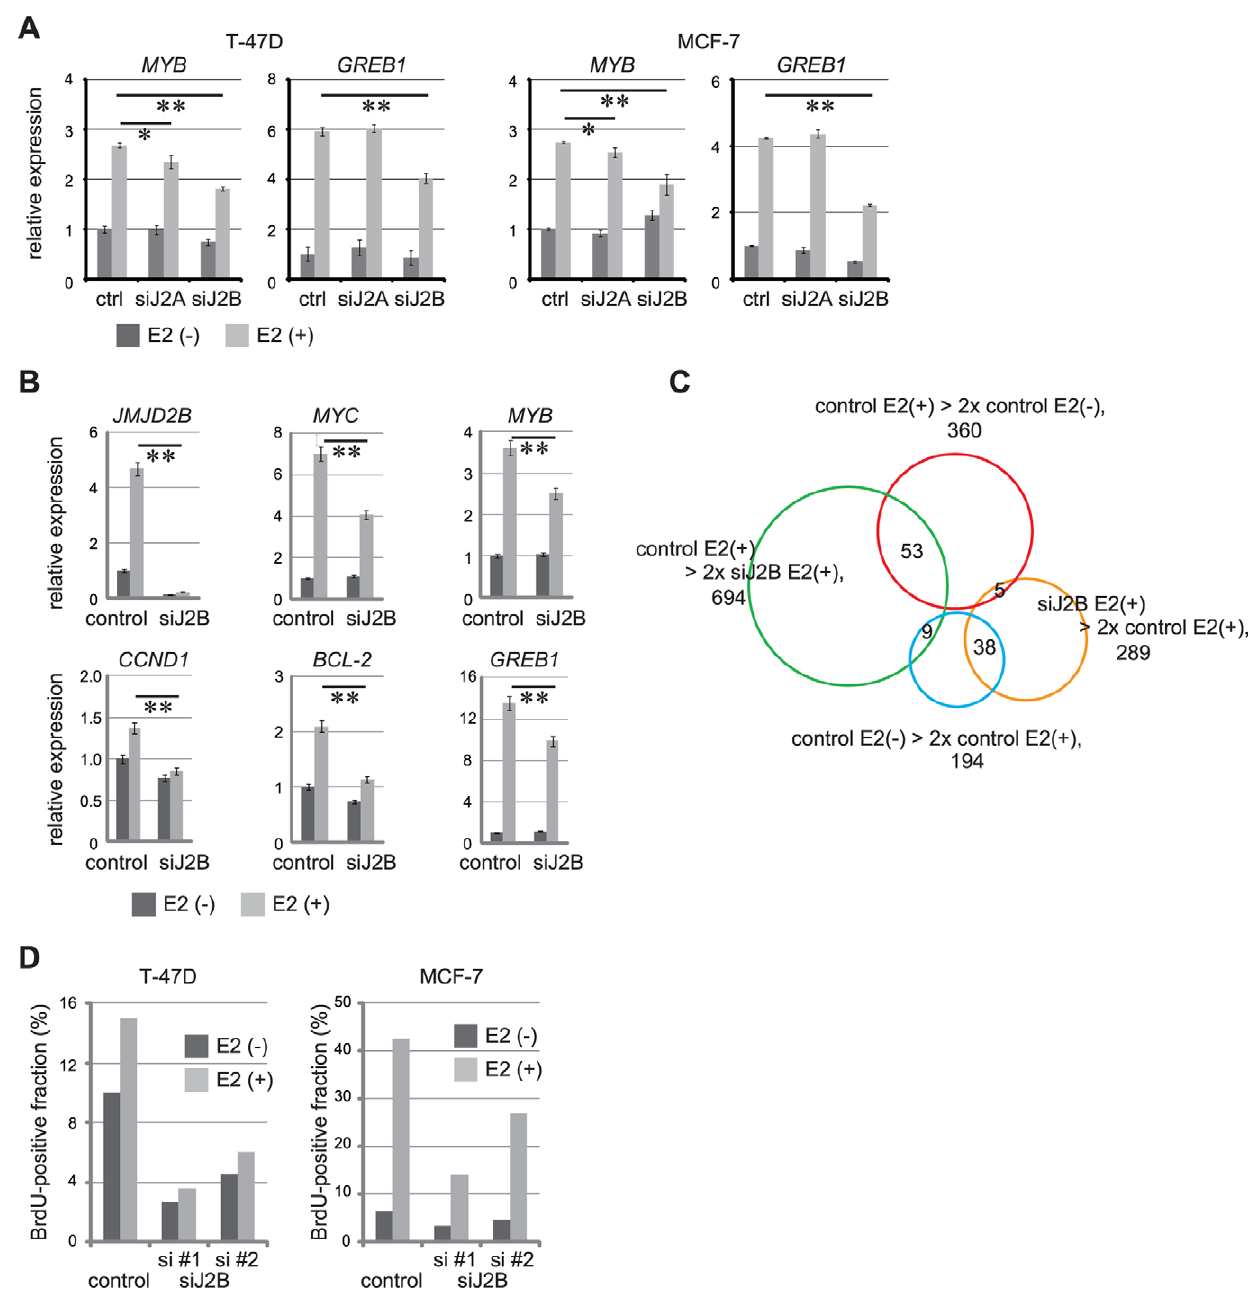
Figure 4. JMJD2B mediates induction of ER target genes and estrogen-dependent proliferation of breast cancer cells. (A) Effect of JMJD2A or JMJD2B knockdown on induction of ER target genes. T-47D cells and MCF-7 cells were transfected with either control siRNA, JMJD2A siRNA or JMJD2B siRNA, cultured in steroid-free medium for 72 hr, and stimulated with or without E2 for 4 hr. (B) JMJD2B knockdown impairs ER target gene induction. T-47D cells were transfected with either control siRNA or JMJD2B siRNA, cultured in steroid-free medium for 72 hr, and stimulated with or without E2 for 4 hr. (A and B) mRNA levels of JMJD2B or the indicated ER target genes were measured by real-time RT-PCR. Results represent mRNA levels normalized to the level of ACTB mRNA (mean 6 s.d. of triplicates). **p , 0.01. (C) Venn diagram representation of the differentially expressed genes. The area of each circle reflects the number of genes contained in the respective categories. The heat map is in Figure S4C. The lists of the genes are in Tables S2, S3, S4, S5. (D) JMJD2B knockdown impairs cellular response to estrogen. T-47D cells or MCF-7 cells transfected with control siRNA or JMJD2B siRNA were cultured in steroid-free medium for 48 hr, stimulated for 24 hr with E2, labeled for 1 hr with BrdU, and stained with anti-BrdU antibody and 7-AAD. The fraction of BrdU-positive cells was determined by flow cytometry. A representative result from three independent experiments.